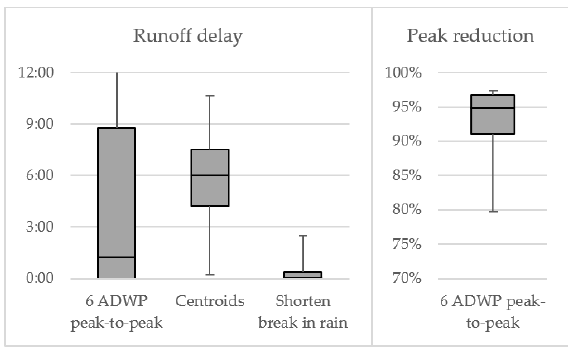
Figure 6. Comparison of the different methods of ( left ) the runoff delay and ( right ) the peak reduction.